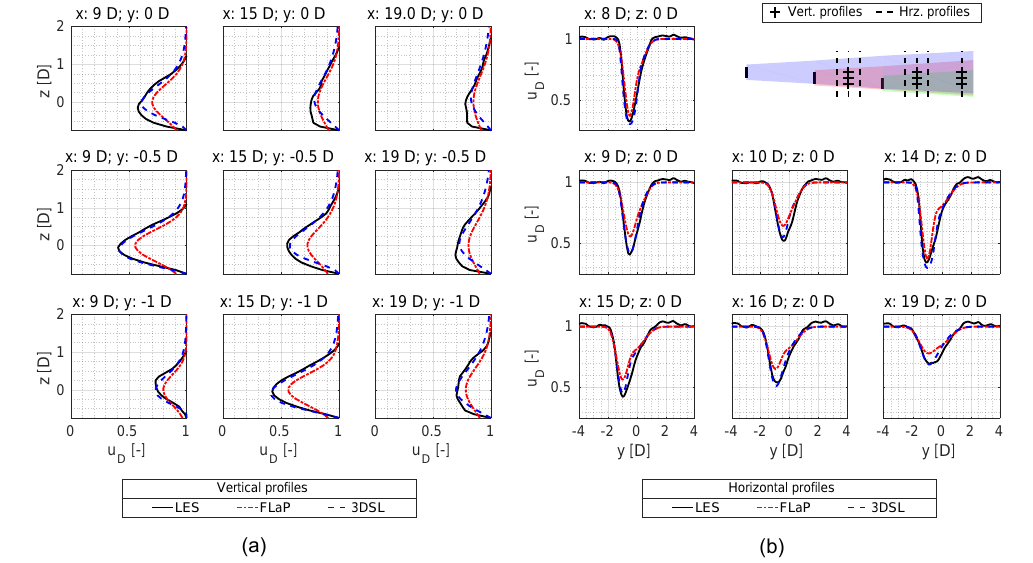
Figure A3. Test case 3 (multiple wakes with 0.5 D lateral separa- tion). Downstream development of the vertical (a) and horizontal (b) profiles of the wake velocity evaluated along the common axis of the wind turbines from the 3DSL model and FLaP simulations and from the reference large-eddy simulation (LES) wind field. The position of the profiles considered is illustrated in the top right cor- ner of (b)